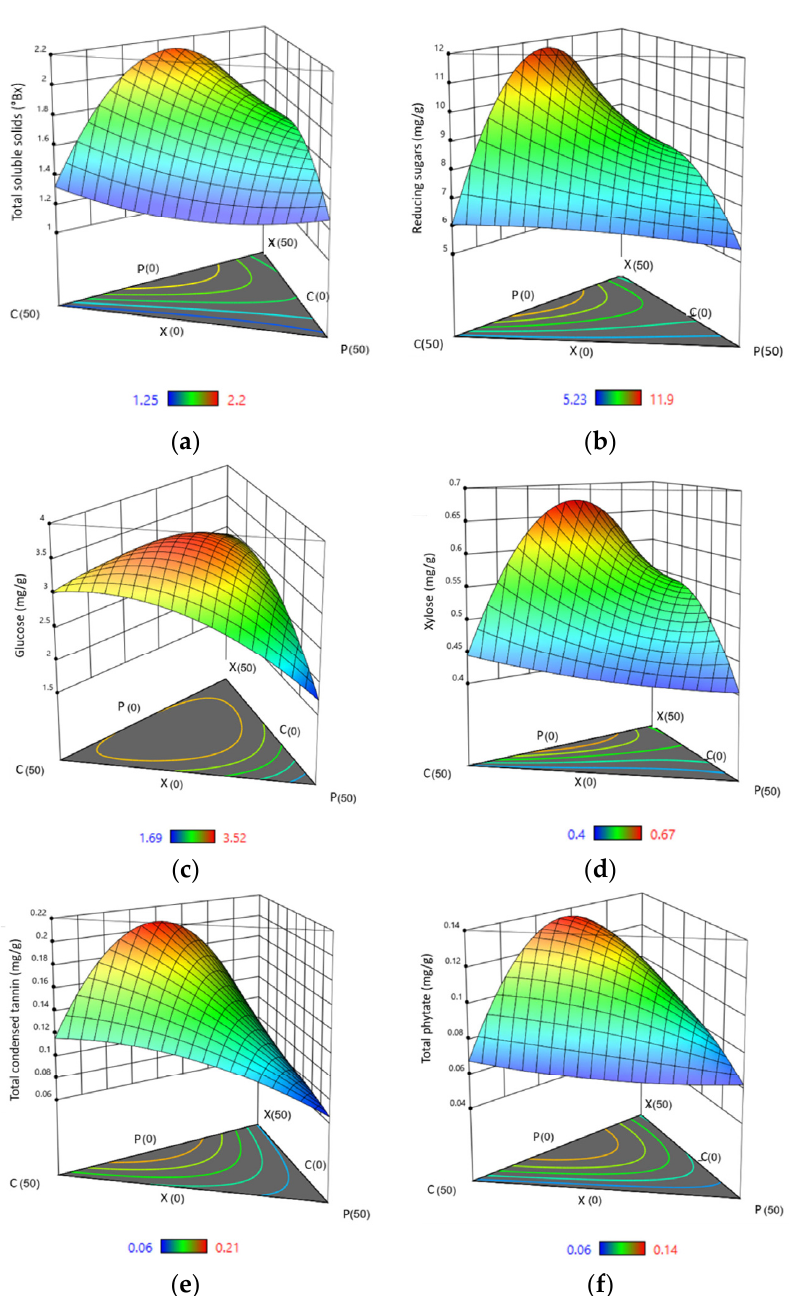
Figure 2. Estimated three-dimensional ternary plots indicating the effect of xylanase, cellulase, and pectinase concentration on ( a ) total soluble solids, ( b ) reducing sugars, ( c ) glucose, ( d ) xylose, ( e ) total condensed tannins, and ( f ) total phytate. X: xylanase, C: cellulase, and P: pectinase.